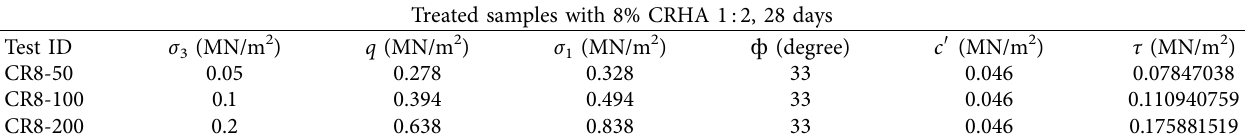
Table 4: CRHA-treated soil mechanical parameters.